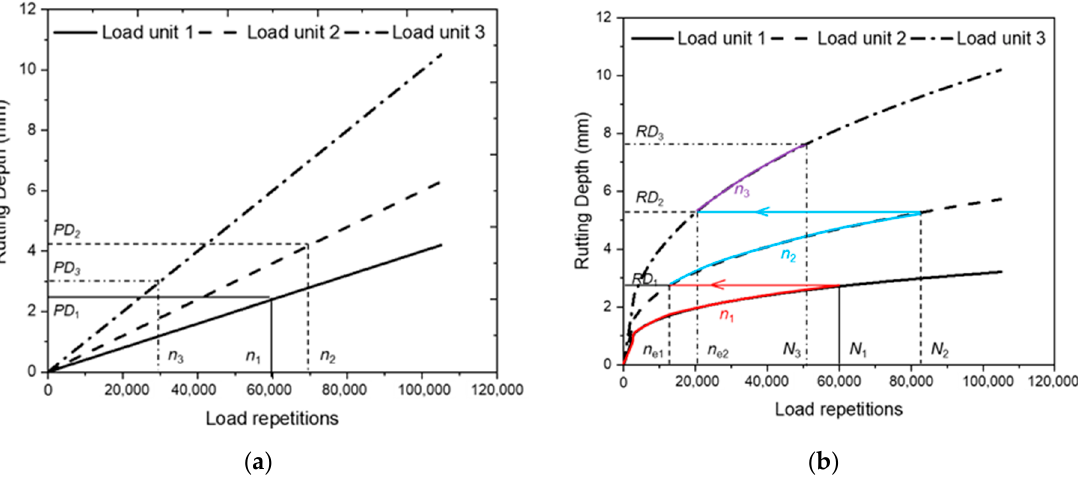
Figure 2. Accumulative rut depth calculation, based on the different principles: ( a ) Miner’s law; ( b ) incremental recursive method. Notes: N 1 = n 1 , N 2 = n e1 + n 2 , N 3 = n e2 + n 3 .